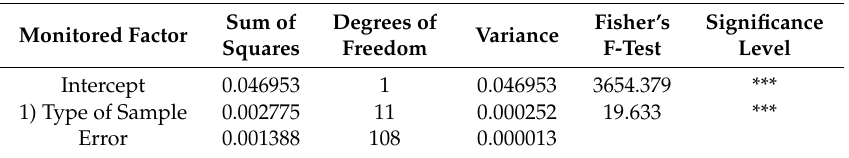
Table 7. Statistical evaluation of the e ff ect of the factors and their interaction on the coe ffi cient of wood bendability ( K bendB ) for aspen and NWC on the bottom.